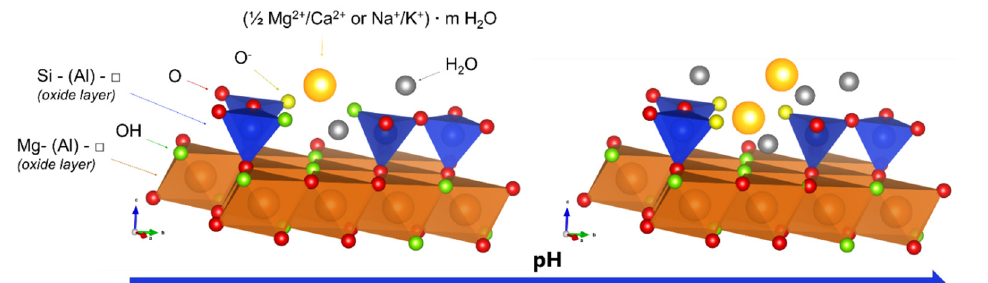
Figure 4. Schematic sketch for the surface of M ‐ S ‐ H where defects are occurring. With the increase of pH, the hydroxyl groups (green) are deprotonated (yellow) and more exchangeable cations are in the surrounding of the layers.